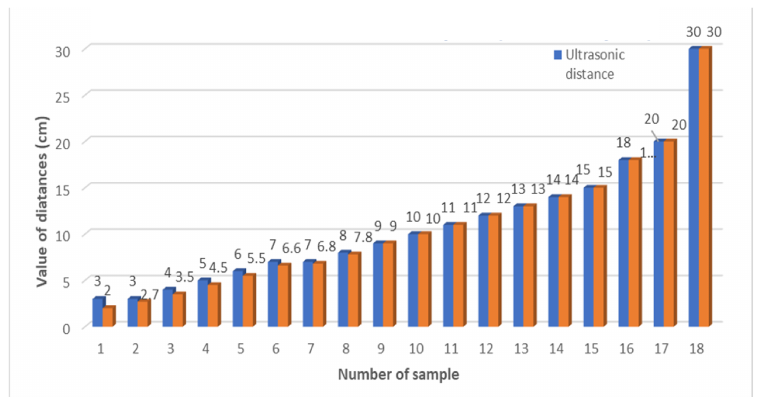
Fig. 9 Comparison of actual distance and ultrasonic distance for metal object over several samples